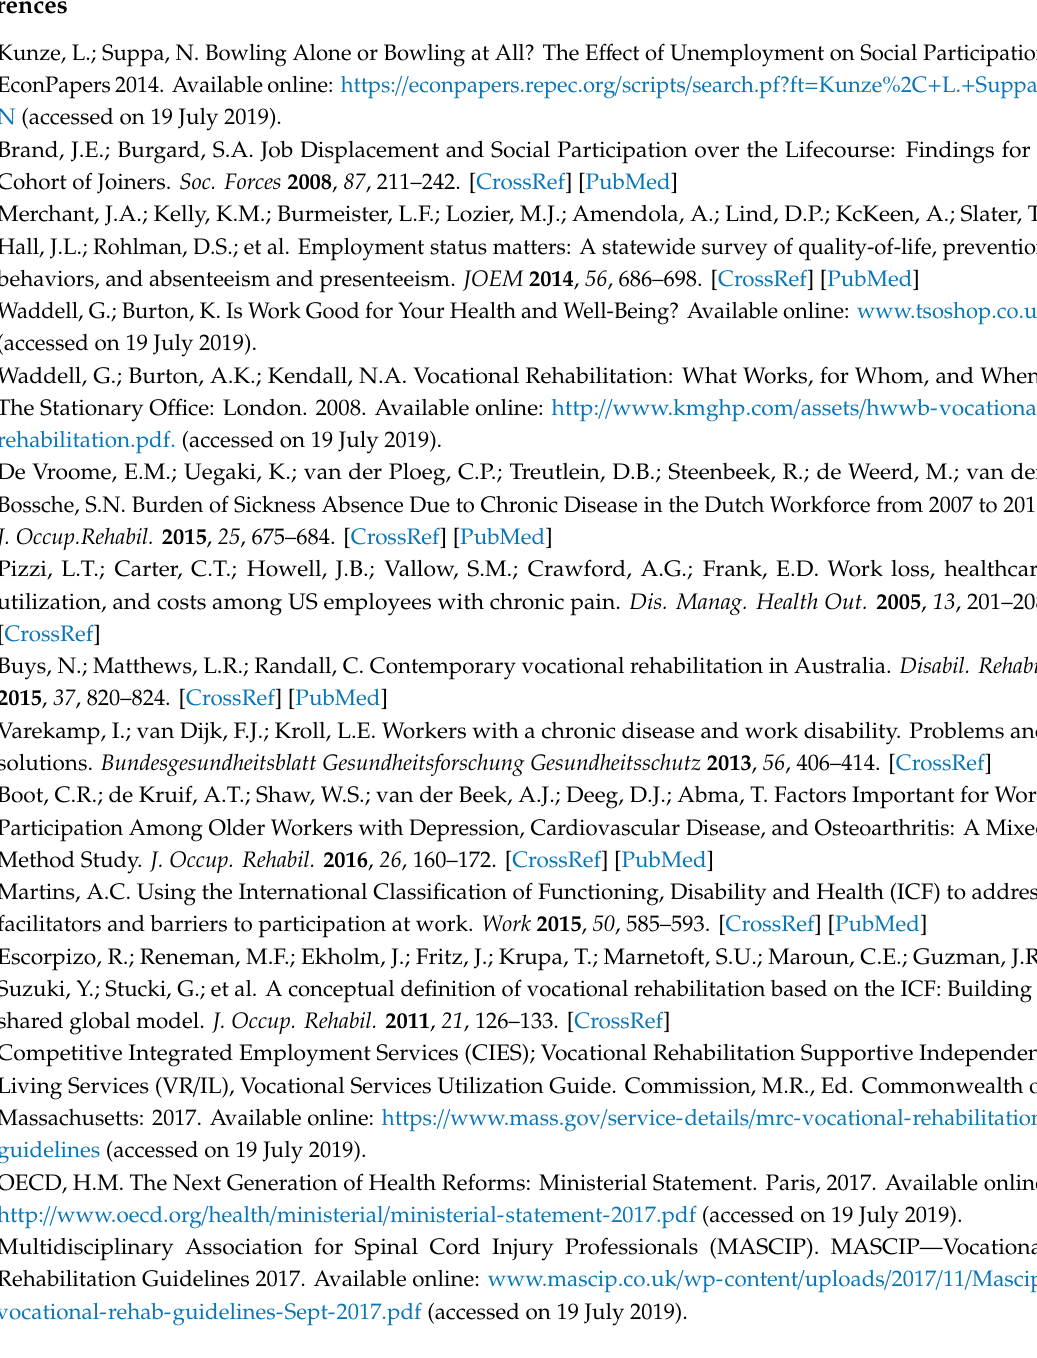
Table S1: Rasch measurement properties of WORQ and WORQ-BRIEF, Table S2: Rasch measurement properties of clinical subscales, Table S3: Transformation